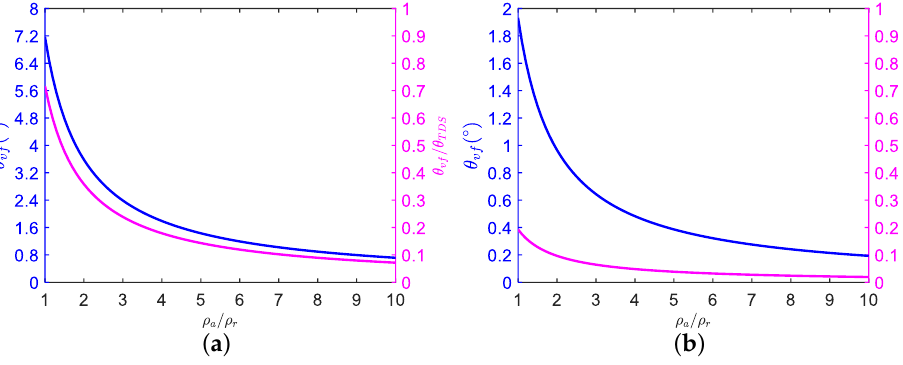
Figure 7. The ratio of OPs to TDSs with a coherent integration angle of 10°. ( a ) X band; ( b ) Ka band with carrier frequency 35.6 GHz. The other parameters are the same as in Table 1. The complete flow diagram of high-resolution ViSAR data processing is shown in Figure 8 and it consists of two main steps: TDS processing, which corresponds to the first part of TFST and FDS processing, which corresponds to the second part of TFST. In (A), the areas marked by red, green and blue boxes, respectively, illustrate the division of TDS in a two-dimensional time domain, which corresponds to Figure 5. Next, M TDSs can be processed by IETSA in parallel and the output is shown in (B). Corresponding to (A), (C) shows the division of N FDSs. Moreover, a geometric correction is applied to remove the distortion introduced by azimuth resampling [23]. The final output is shown in (D); thus, a series of video frames for generating video are